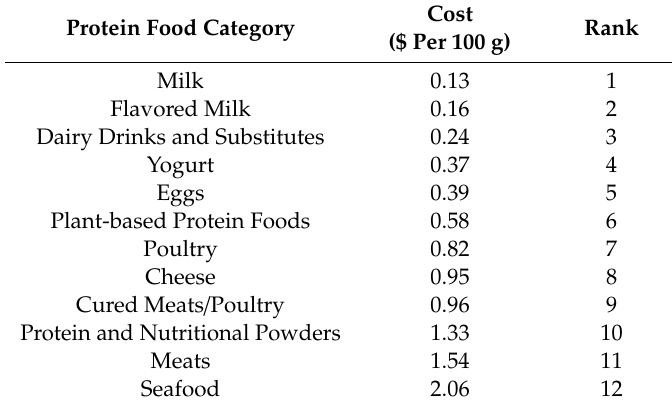
Table 2. Mean cost of USDA dairy and protein food subgroups compared to eggs. Protein Food